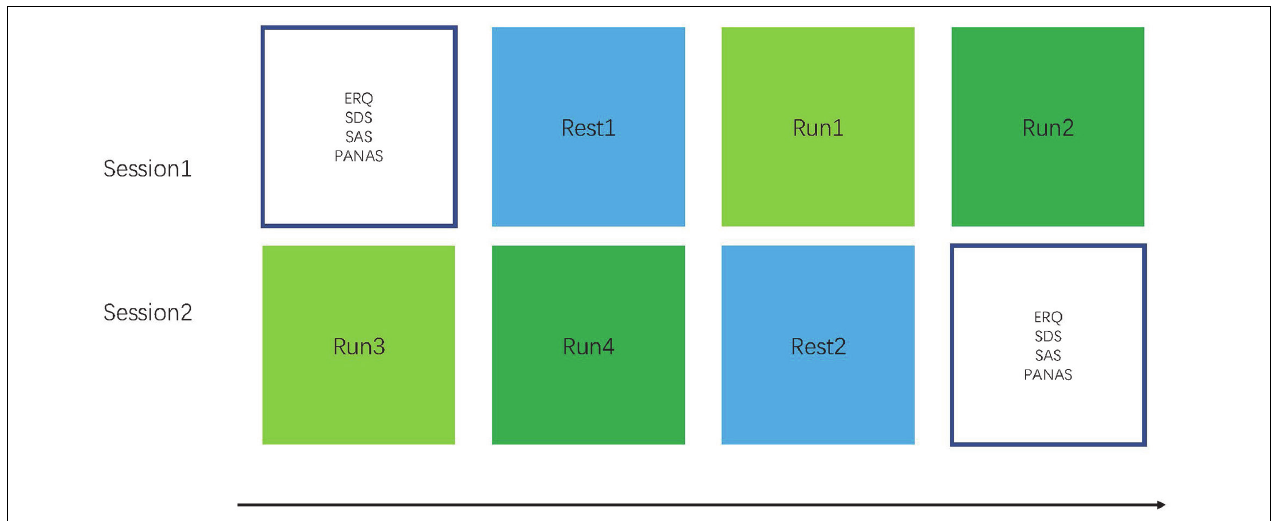
FIGURE 1 | Experimental procedure: The experiment consisted of six runs with a length of 6 min 20 s each. In the beginning of the experiment, a localizer is used for hippocampus mask positioning (participants are instructed to relax). During the four training runs, the participants performed NF-based neurofeedback (NF)-based regulation of hippocampus. For the rest run, the participants are instructed to open their eyes, fixate on a cross, relax, and not think about anything in particular.